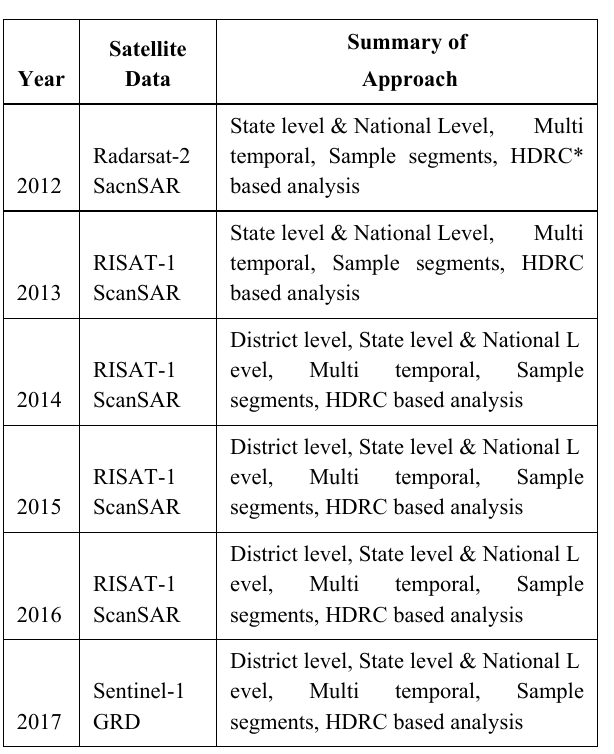
Figure 2. Paddy area in Krishna, Guntur Districts of Andhra Pradesh: Colour composites of 28 July (Red),21 August (Green), 14 September (Blue)